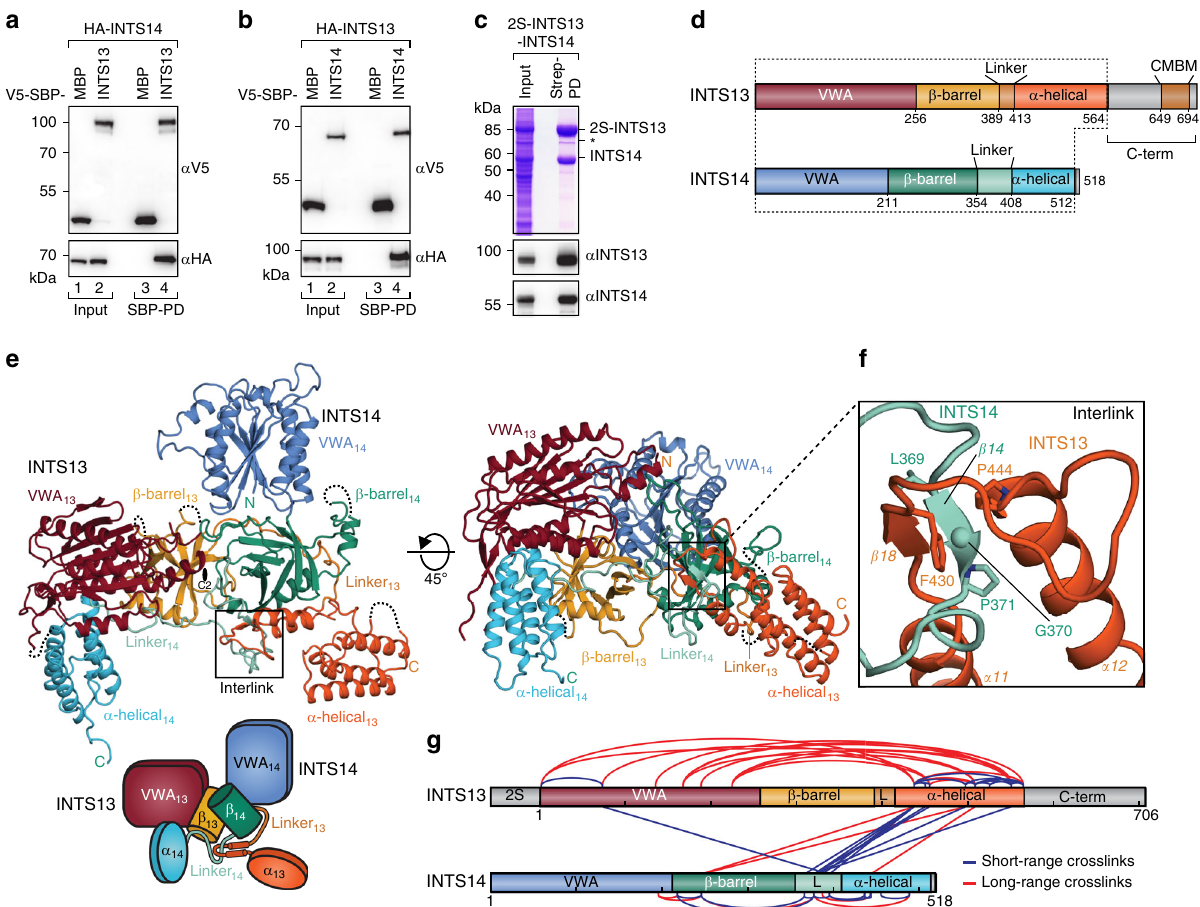
Fig. 1 INTS13 and INTS14 form an interlinked heterodimer. a Coprecipitation experiments of λ N-HA-tagged INTS14 with V5-SBP-tagged INTS13 from HEK293T cells using streptavidin beads. V5-SBP-MBP served as a negative control. Inputs ( α V5-blot 1%, α HA-blot 0.38%) and bound fractions ( α V5-blot 7.5%, α HA-blot 20%) were analyzed by Western blotting. b Same experiment as in a but with λ N-HA-INTS13 and V5-SBP-INTS14. c Copuri fi cation of INTS14 with 2S-tagged INTS13 from insect cells expressing both proteins. The identity of proteins on the Coomassie-stained gel was veri fi ed by Western blotting. The asterisk marks a C-terminal degradation product of INTS13. C-terminal truncations of INTS13 are not detected by the speci fi c antibody. d Domain organization of INTS13 and INTS14 as observed in the crystal structure of the complex. The dotted line marks portions of both proteins that are visible in the structure. CMBM marks the cleavage module-binding motif identi fi ed in this study. e Structure of the INTS13 – INTS14 complex colored as in d . The two-fold rotation axis (C2) for the pseudosymmetry is indicated by a black oval. The position of the chain interlink is marked by a black box. The cartoon provides a simpli fi ed schematic for the domain arrangement of the complex. f Close-up of the interlink between INTS13 (dark orange) and INTS14 (light blue). g DSS crosslinks between Lys residues of INTS13 and INTS14 as determined by XL – MS. Crosslinks between residues that are visible in the crystal structure are shown, including crosslinks within the INTS13 – INTS14 complex (blue) and crosslinks stemming most likely from complex oligomerization (red). Domain schemes are colored as in d and every 100th residue is marked with a tick. L indicates linker